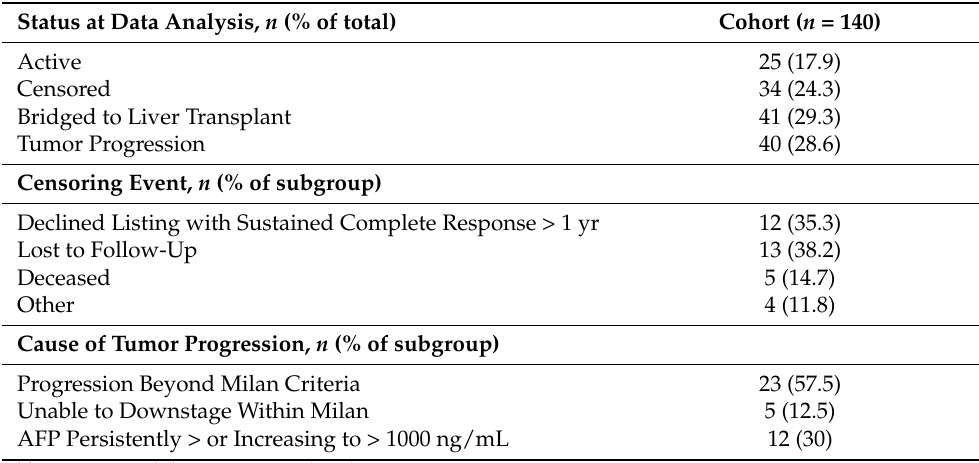
Table 2. Bridge to Transplant Cohort Outcomes.